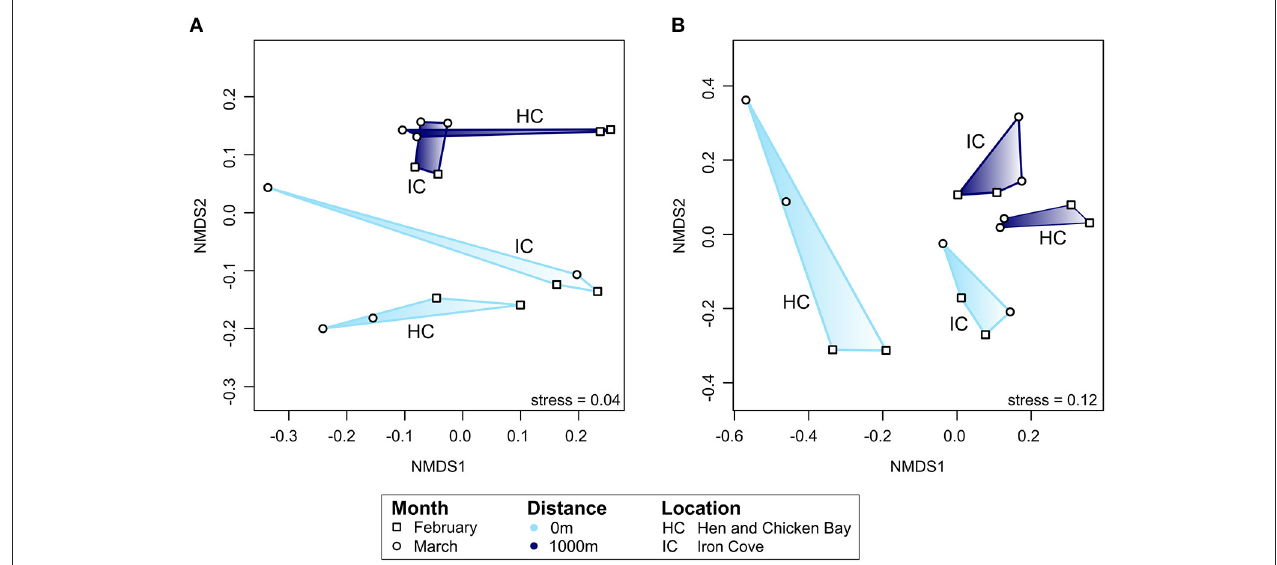
FIGURE 7 | Ordination analyses of the composition of the active bacterial community [rRNA; (A) ] and assembled non-rRNA transcripts (B) . Only transcripts with known functional annotation were included in the analysis. Ordination is based on Bray-Curtis dissimilarities between samples and is colour-coded by distance from storm drain. Different symbols represent the two sampling months, February or March. Note that the nMDS axes have different scales for each ordination. The ordination plot for all (total) non-rRNA transcripts and those transcripts without known functional annotation can be found as Supplementary Figure 6 . Data included in Supplementary Table 4 . IC, Iron Cove; HC, Hen and Chicken